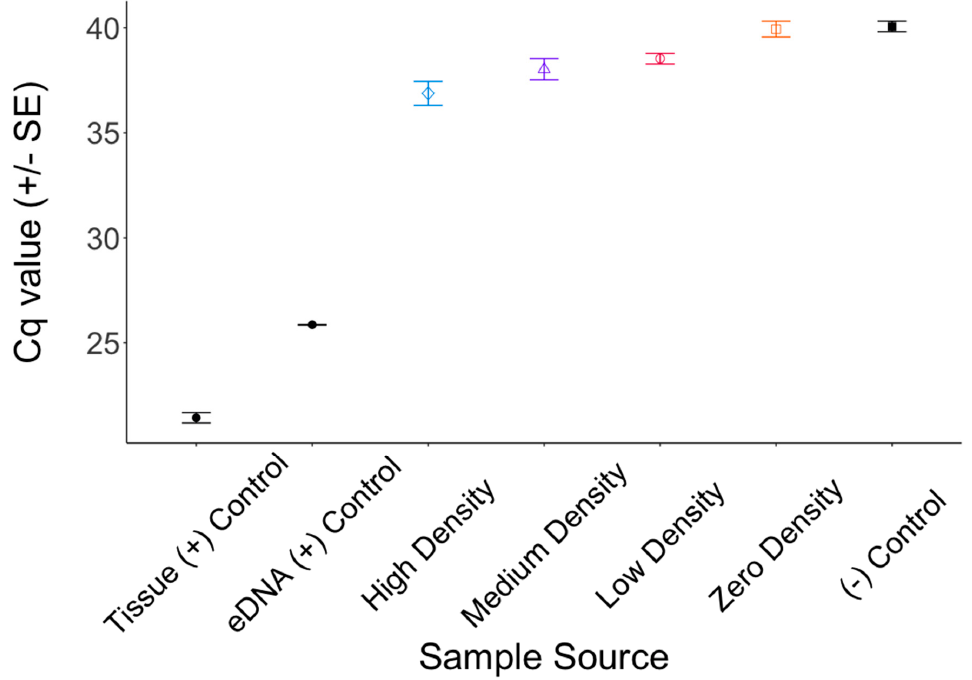
Figure 3. Plot of Cq mean per sample source with the standard error of the mean (SE) for painted turtle eDNA from water samples obtained from experimental ponds during the 2016 field season. Higher Cq values indicate lower eDNA. Varying colors and symbols represent pond treatments: the zero-density pond had 0 turtles (orange squares), the low-density pond had 11 turtles (red circles), the medium-density pond had 23 turtles (purple triangles), and the high-density pond had 38 turtles (blue diamonds). See Figure 2 for more information.